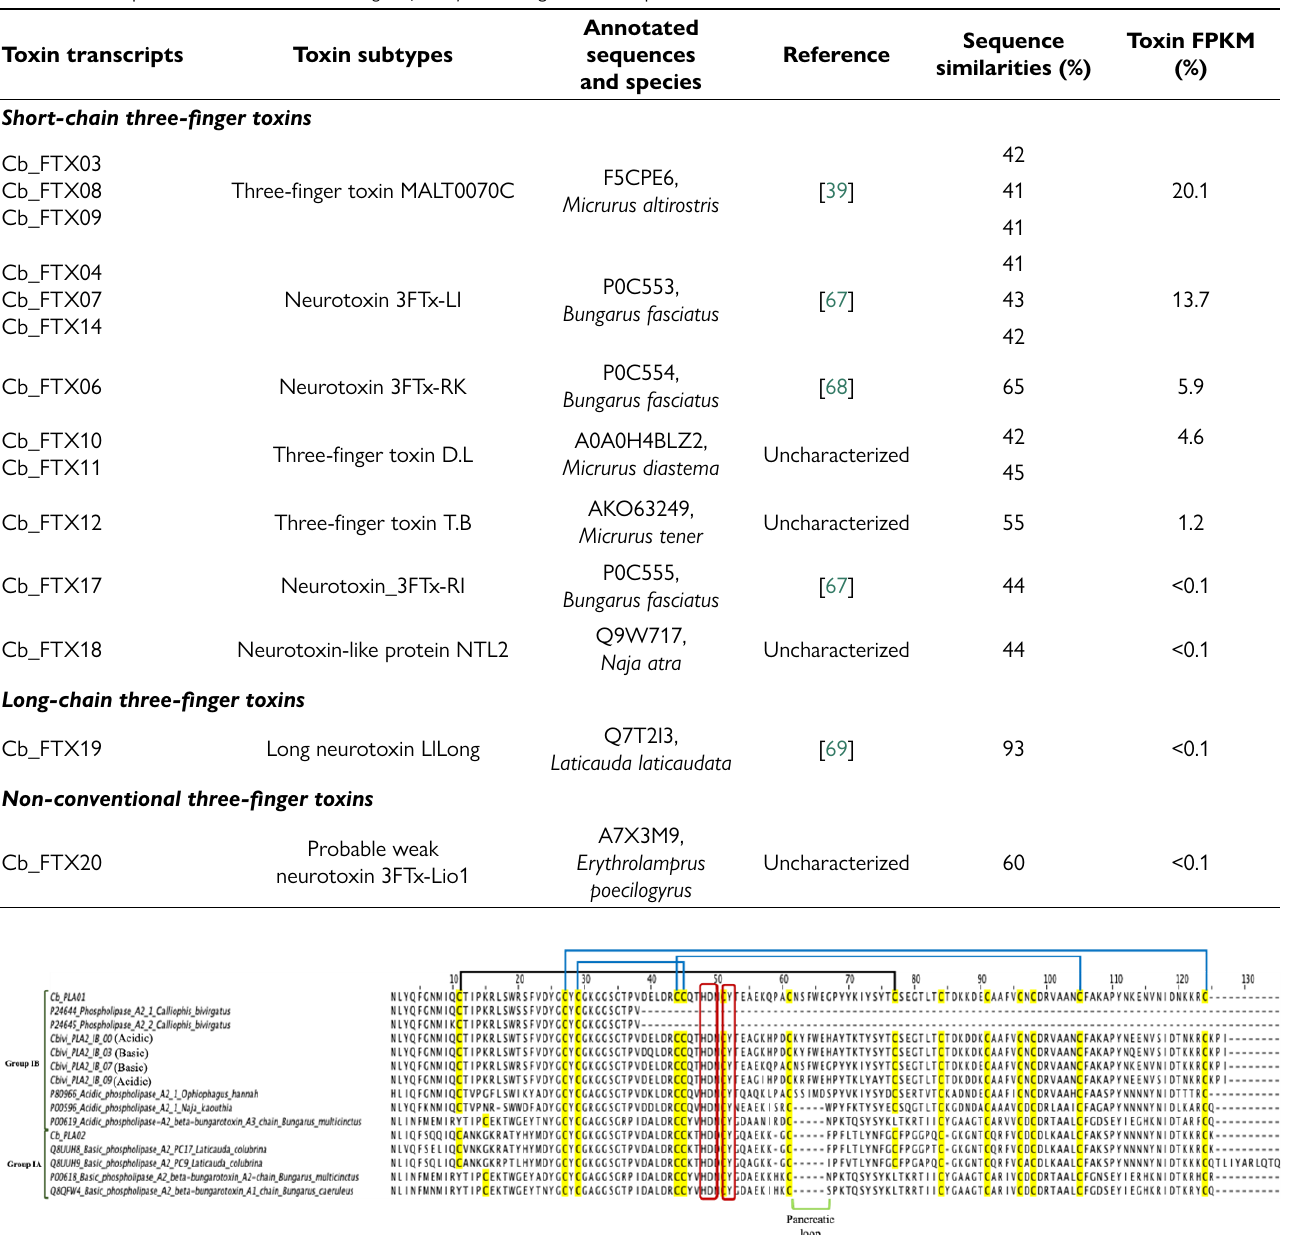
Figure 6. Multiple sequence alignment of snake venom phospholipase A and compared to closely related sequences from public database. Brackets in blue and green: conservative disulfide bonds and residues of pancreatic loop; black: additional disulfide bridges; red box: conserved amino acid